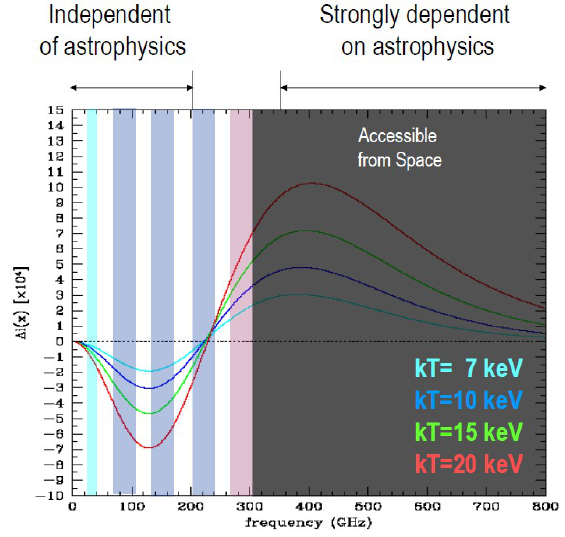
Figure 1: Thermal SZE spectrum of galaxy clusters with different plasma temperatures (as indicated) and the same value of the optical depth. The low- ν part ( ν ∼ < 220 GHz) of the spectrum depends mostly on the total Compton parameter y ∝ (cid:82) d(cid:96)P tot with no strong spectral dependence on the temperature. The high- ν part of the spectrum (at ∼ > 300 GHz) shows a strong spectral dependence from the plasma temperature [17].